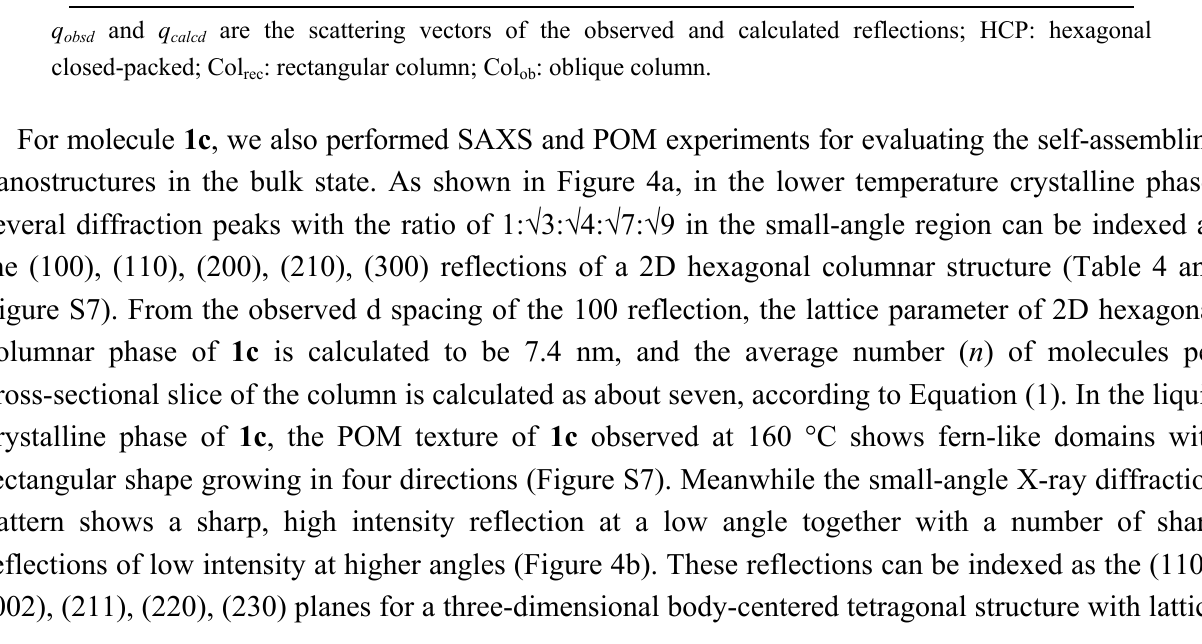
Table 3. Small-angle X-ray diffraction data for molecule 1b in the bulk state. Mesophase (lattice constants) Col at 30 ° C rec b = 5.2